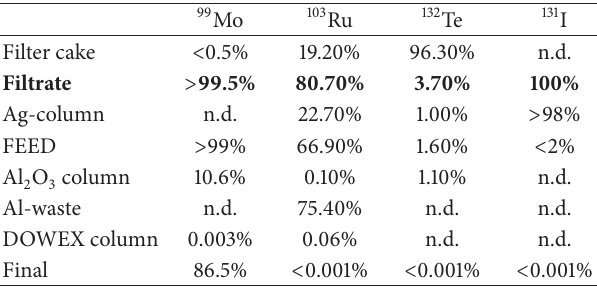
Table 5: Radioactivity distribution of 99 Mo and the most important impurities during the process.